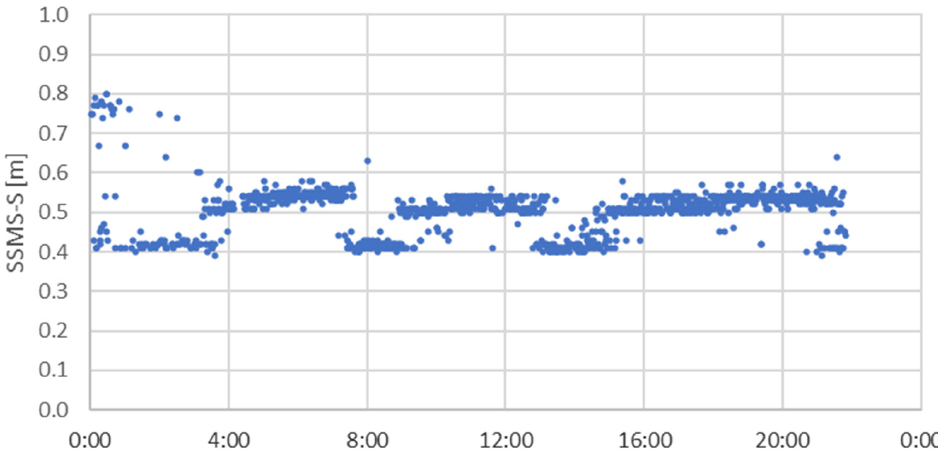
Figure 8. SSMS-S 23 August 2020 roof support No. 116.